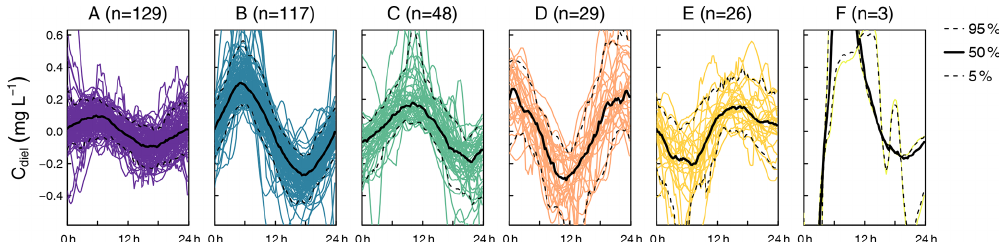
Figure 2. Clusters found in diel residuals of NO − concentration ( C diel ). Capital letters above panels are cluster names ordered alphabetically 3 according to cluster size. Black lines indicate median diel patterns, and dashed lines indicate the 5th and 95th percentiles. Note that C diel reflects deviations from the 24h floating average so that negative values do not imply that negative concentrations were observed.